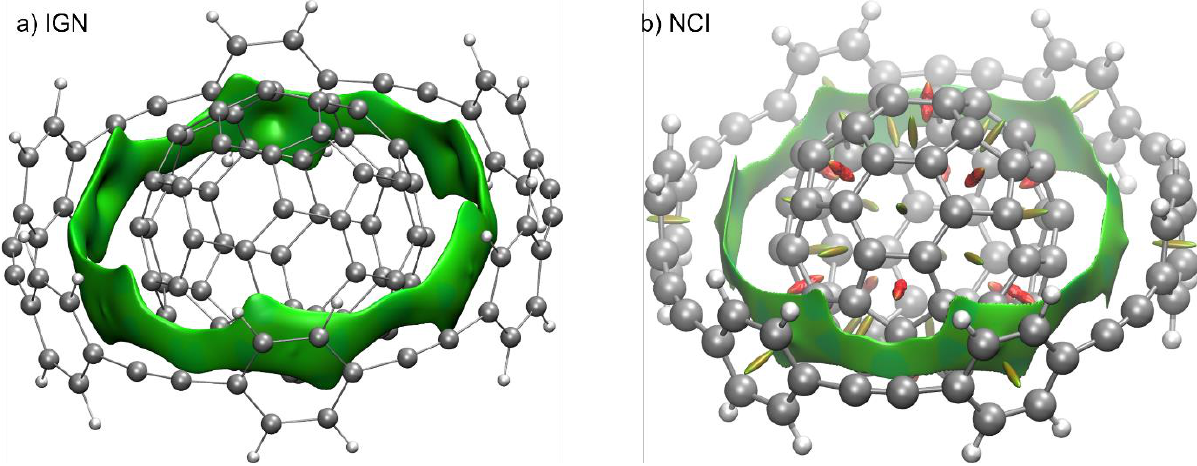
Figure 28. (a ) IGM isosurface and ( b ) NCI isosurface generated with densities at B3LYP/6-31G(d). Visualization was done with VMD [197].